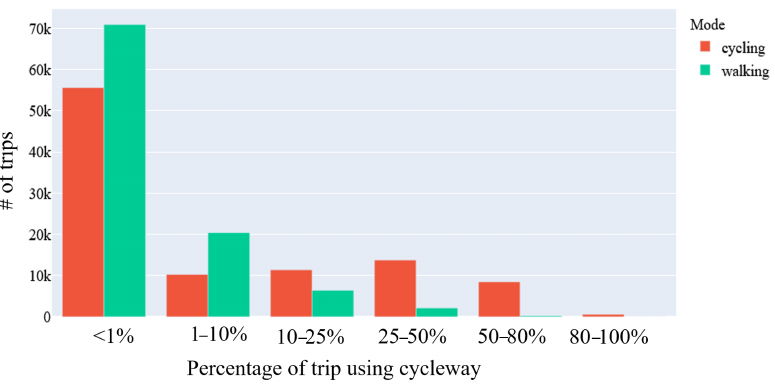
Figure 11. Percentage of cycleway used per trip for all modes using MSS in